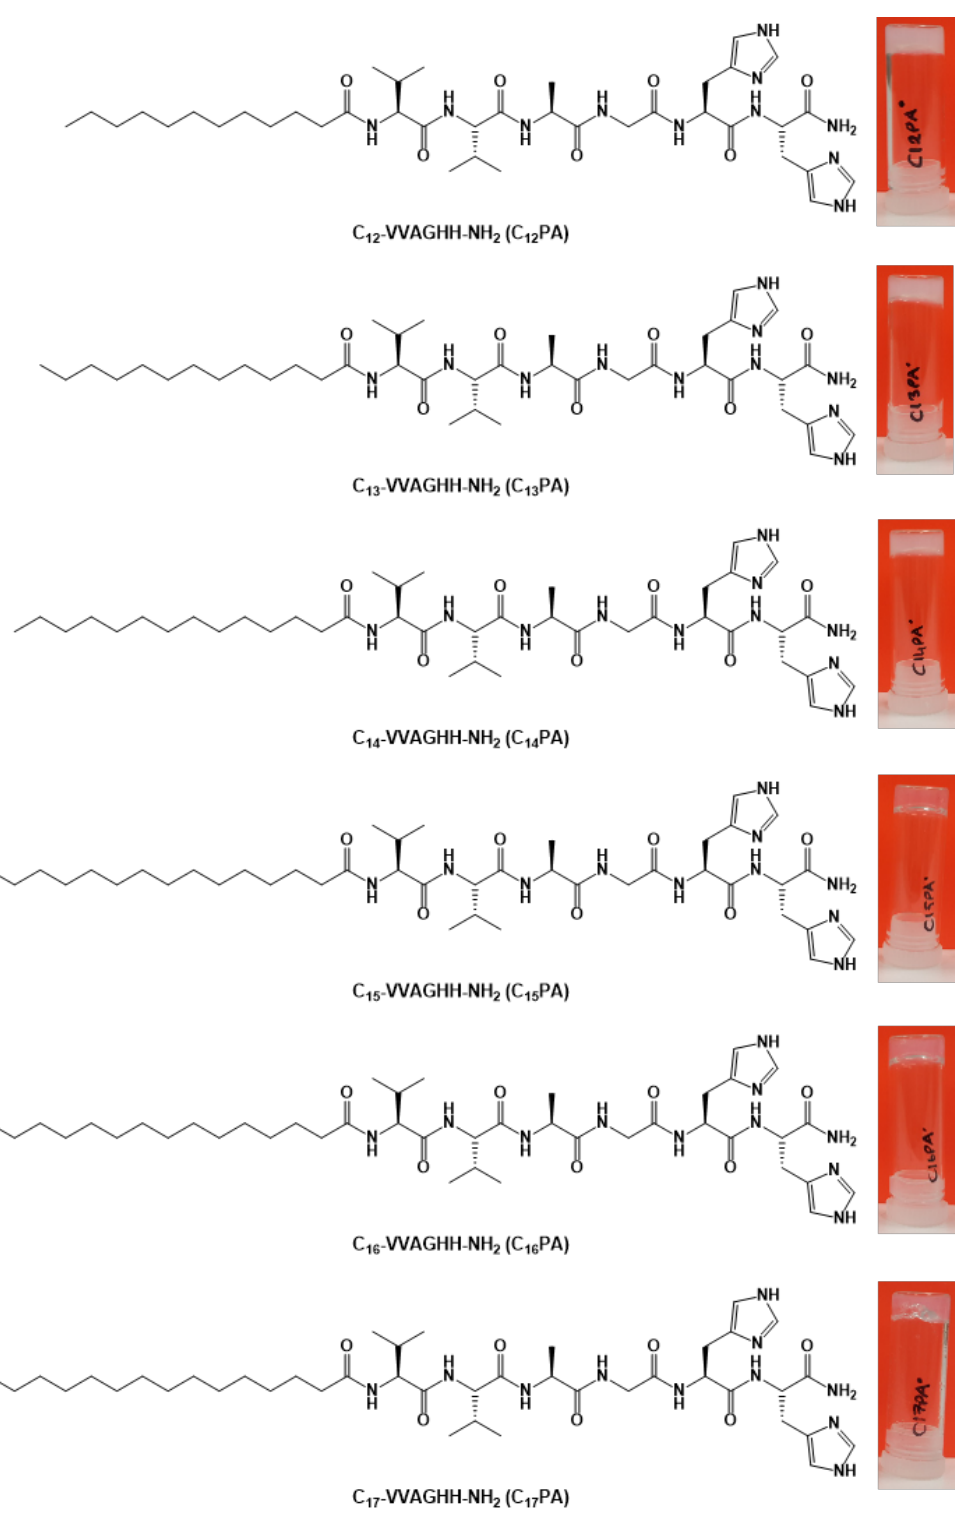
Figure 1. Structural formulas of the synthesized peptide amphiphiles and representative pictures of their corresponding